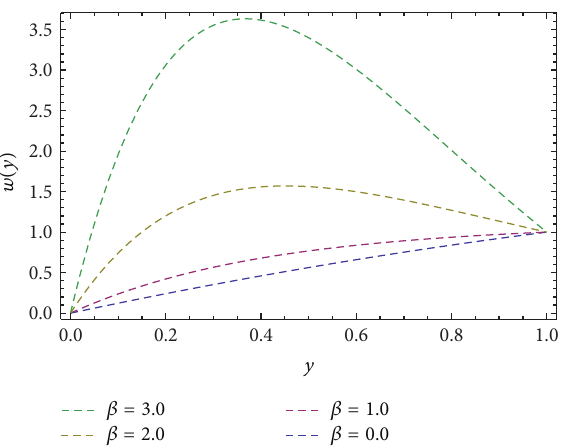
Figure 5: Velocity profile 𝑤(𝑦) for different values of 𝛽 , keeping 𝜕𝑃/𝜕𝑧 = −0.5 , 𝛼 = 1.0 , and 𝜙 = 45 ∘ .